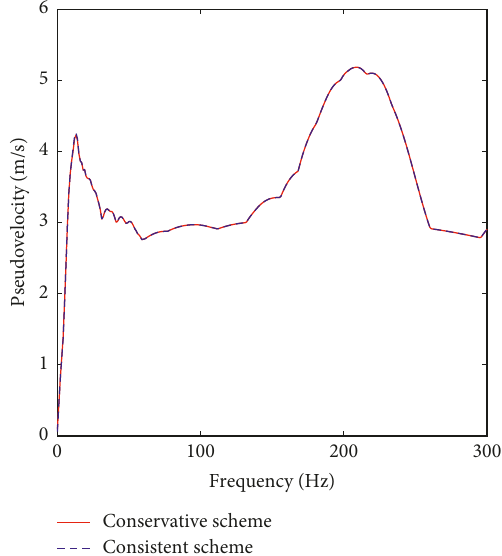
Figure 17: Comparison between consistent and energy-conser- vative approach in SRS.